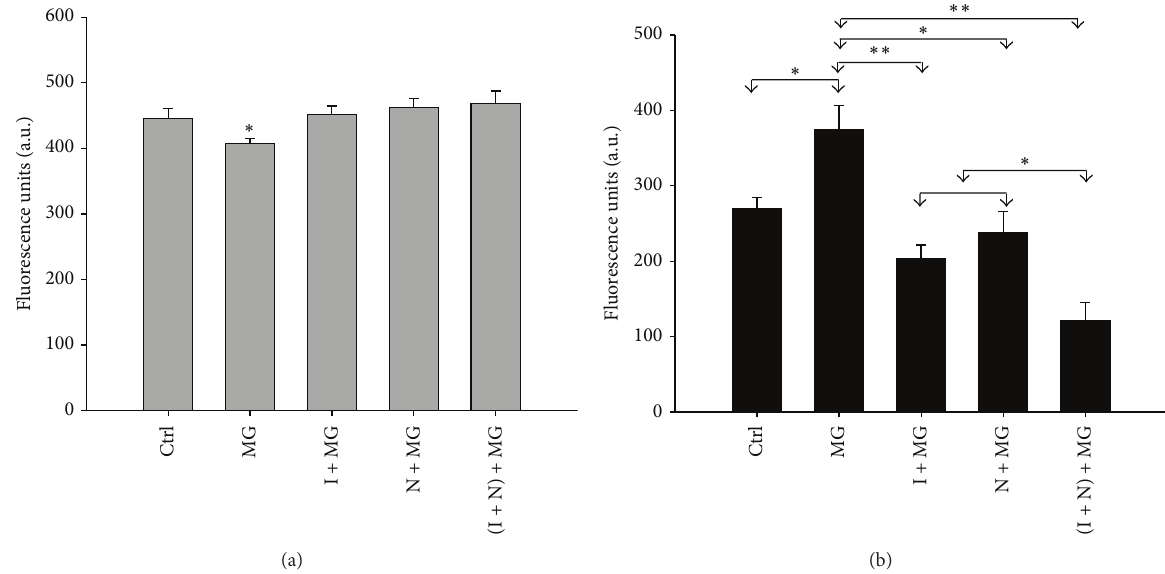
Figure 3: IGF-1 and NAC increase GSH production and reduce MG132 induced ROS generation in SH-SY5Y cells. Cell cultures were treated with NAC or IGF-1, separately or together, as described for Figure 1, followed by MG132 (5 𝜇 M). (a) Glutathione assay results for the control and treated cells versus MG132 treated cells only. (b) Intracellular ROS levels. Level of significance is denoted as ∗ 𝑝 ≤ 0.05 and ∗∗ 𝑝 ≤ 0.005